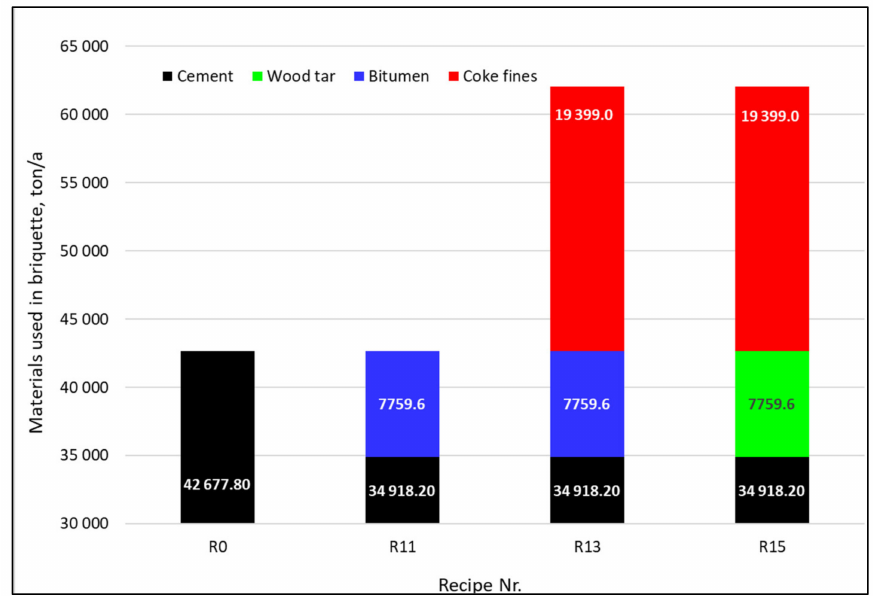
Figure 13. Annual consumption of binders and coke fines in developed